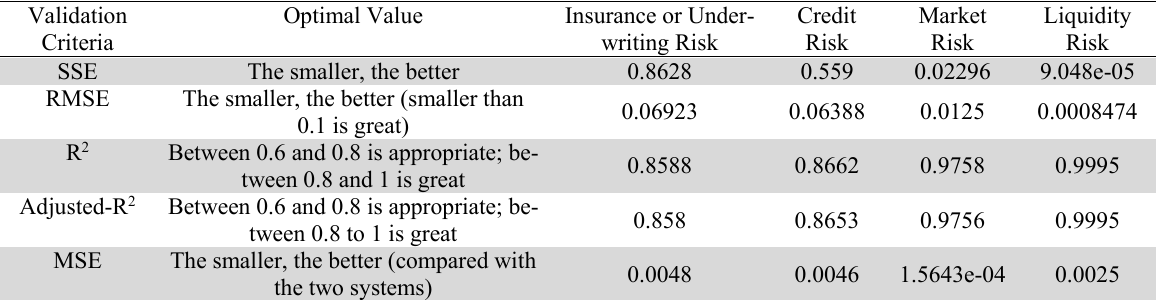
Fig. 7. The Output of Liquidity Risk Neuro-Fuzzy Network for Testing Data The Statistical Features of ANFIS